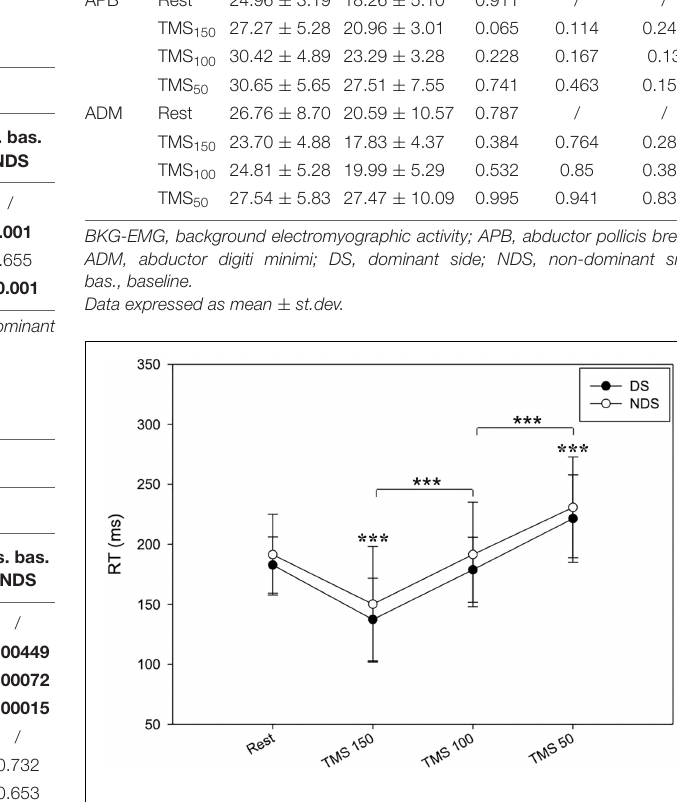
( Figure 3A and Table 2 ) (rmANOVA DS: F = 5.8; p = 0.001; NDS: F = 4.87; p = 0.003), confirming the occurrence of